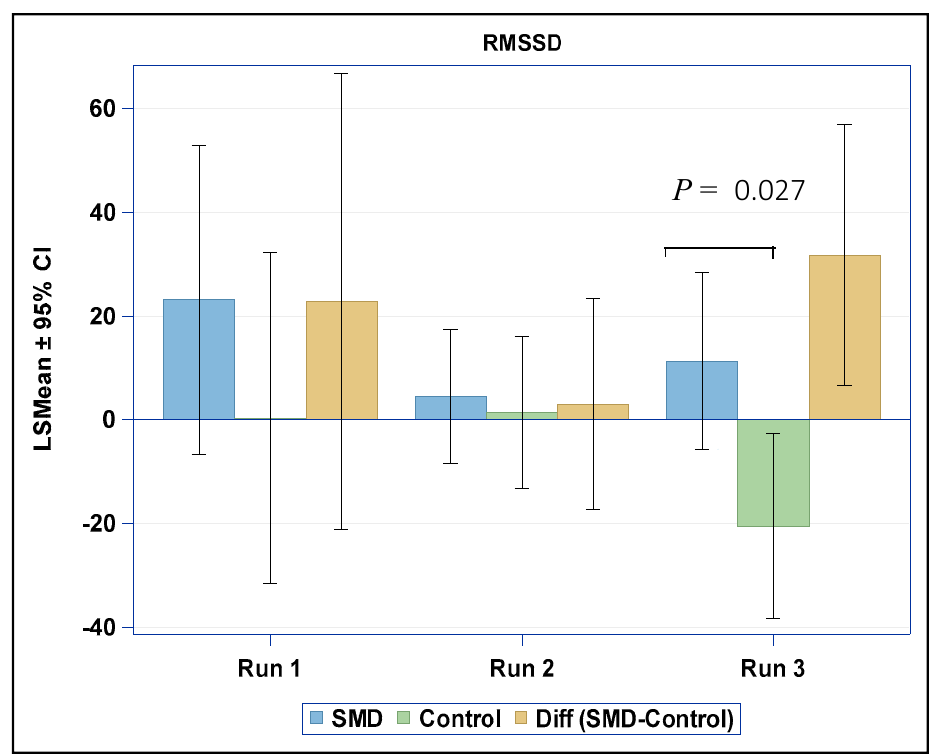
Figure 2. Changes in RMSSD from baseline to reactive phases in both groups. RMSSD: root mean square of successive differences.